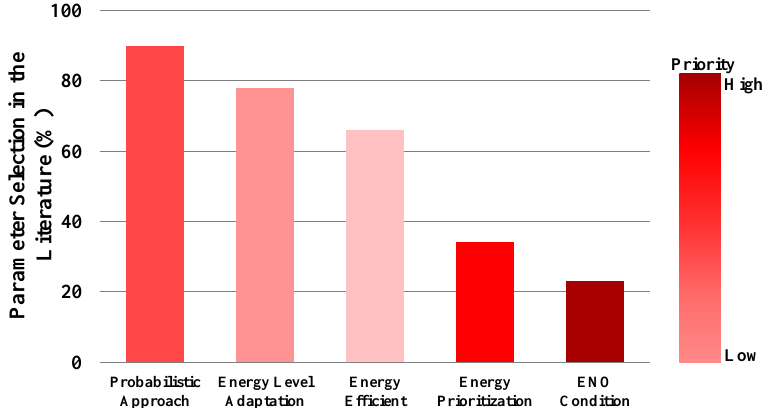
Figure 7. General comparison of energy-related parameters in energy harvesting MAC